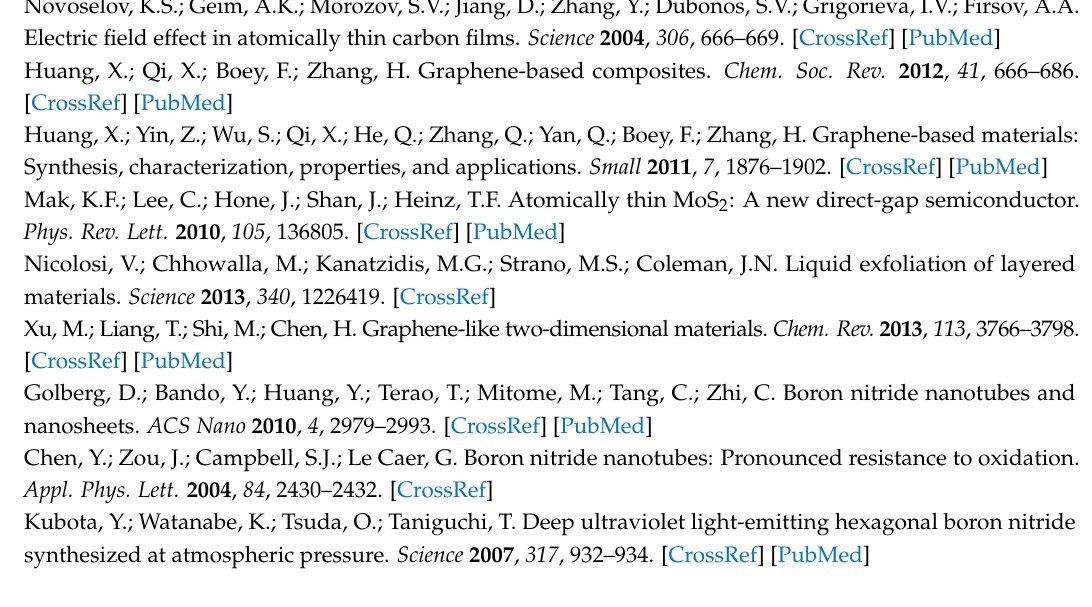
Figure S1: XRD patterns of exfoliated h-BNNS in presence of ZnCl 2 without further washing, Figure S2: (a) EDX image of h-BNNS exfoliated with 1.0 wt % ZnCl 2 ; (b) Element mapping images of the h-BNNS exfoliated with 1.0 wt % ZnCl 2 , Table S1: EDX descriptive analysis of h-BNNS exfoliated with 0.5 wt % and 1.0 wt % KCl, Table S2: EDX descriptive analysis of h-BNNS exfoliated with 0.5 wt % and 1.0 wt % ZnCl 2